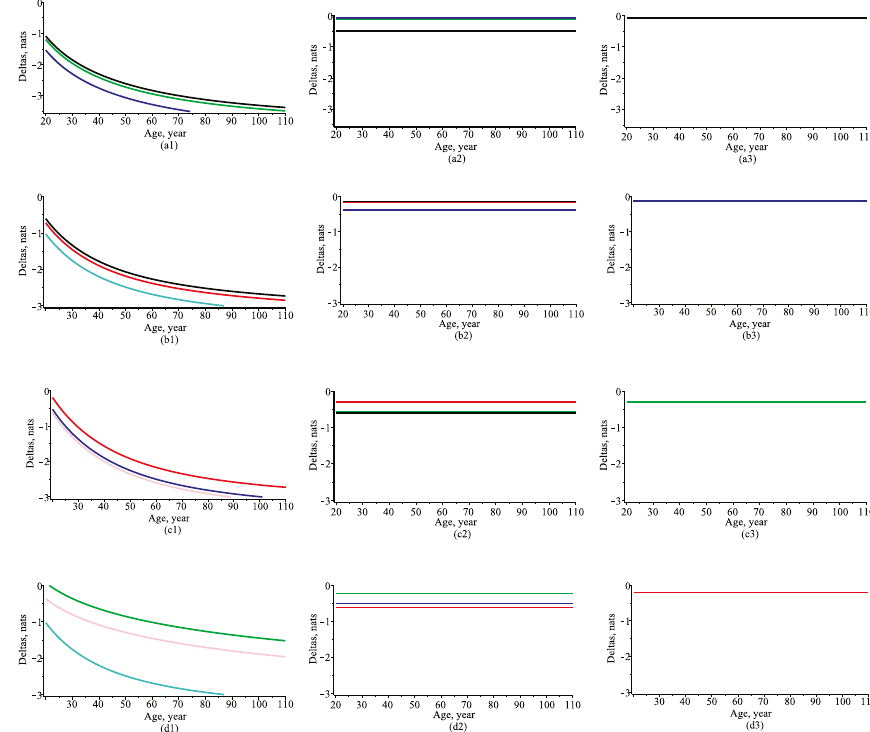
Figure 6. Evolution of deltas (Equations (60)–(62)). Left column—Equation (60). Middle column—Equation (61). Right column—Equation (62). First row demonstrates for diameter as a target variable. Second demonstrates for height as a target variable. Third row demonstrates for crown base height as a target variable. Fourth row demonstrates for crown width as a target variable. ( a1,b1,c1,d1 ): black—diameter and height; blue—diameter and crown base height; green—diameter and crown width; red—height and crown base height; cyan—height and crown width; pink—crown base height and crown width. ( a2,b2,c2,d2 ): black—height, diameter and crown base height; blue—height, diameter and crown width; green—diameter, crown base height and crown width; red—height, crown base height and crown width. ( a3,b3,c3,d3 ): all tree size